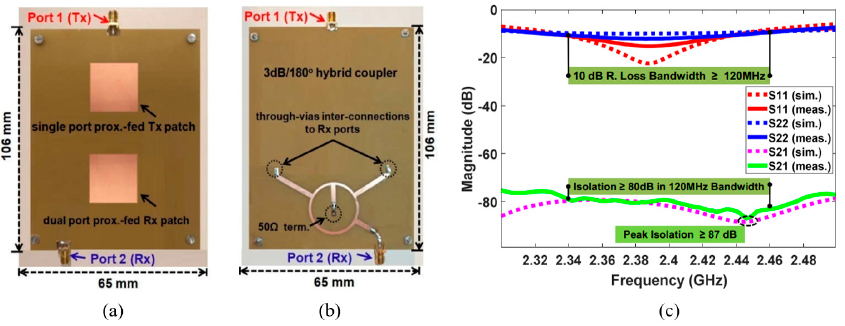
Figure 8. Proposed IBFD antenna with state-of-the-art SIC performance in [54]. ( a ) Antenna elements (top view). ( b ) Ring coupler (bottom view). ( c ) Reflection and transmission coefficients (S parameters).